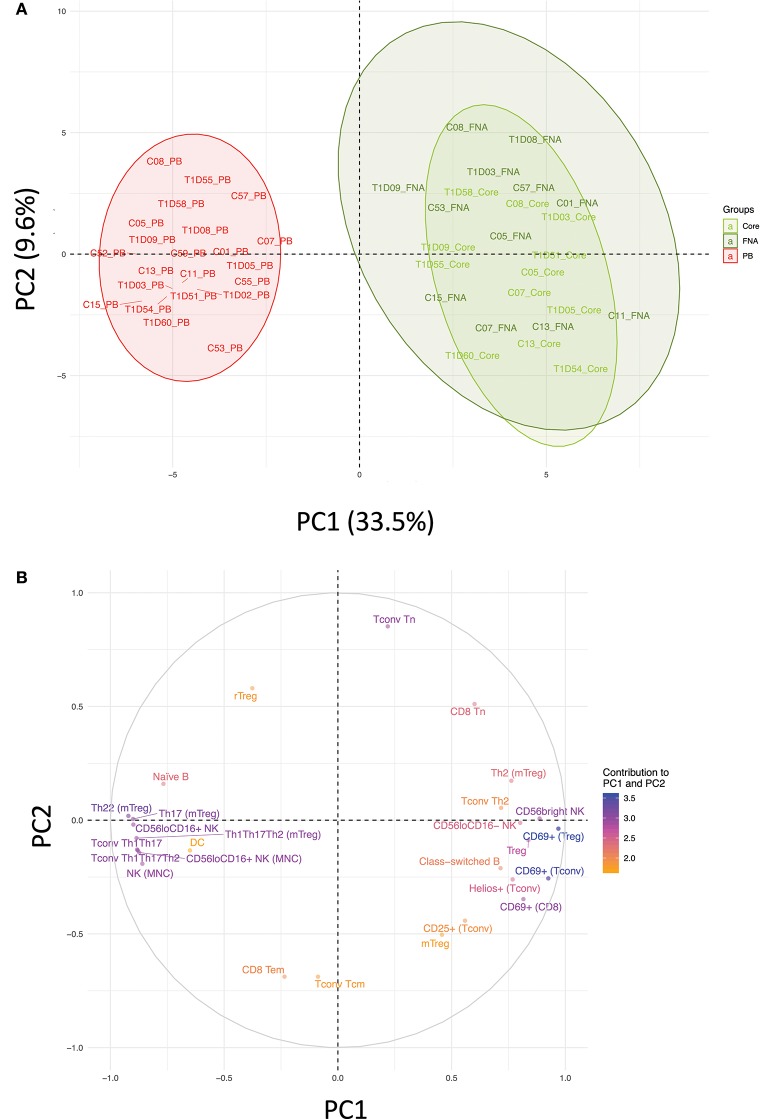
Immune profiles in blood and iLN biopsies differ but cells from FNA and core biopsies are similar. Principle component analysis (PCA) was performed on leukocyte subpopulation frequencies (n = 61) in peripheral blood (PB) and iLN biopsies. (A) Plot showing the two major principle components of leukocyte subpopulation frequencies from blood, LN fine needle aspirates (FNA) and core biopsies (Core) from all control and T1D subjects (n = 12 and n = 10, respectively). Individual samples identifiers are as explained in Figure 1. Shaded areas represent 95% confidence ellipses of the mean for each tissue. (B) Loading plot indicating how strongly and in which direction each individual variables affect the two major principle components (PC1 and PC2). The top 27 variables contributing to PC1 and PC2 are displayed and their relative influence expressed as a percentage (low% = orange, high% = blue) based on the average contribution of all variables to the PC.